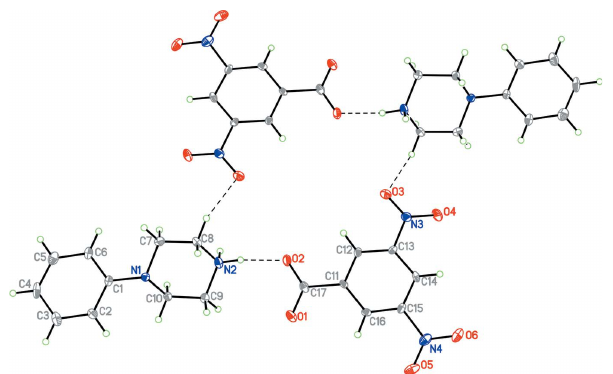
(8) chains made up of N— 2